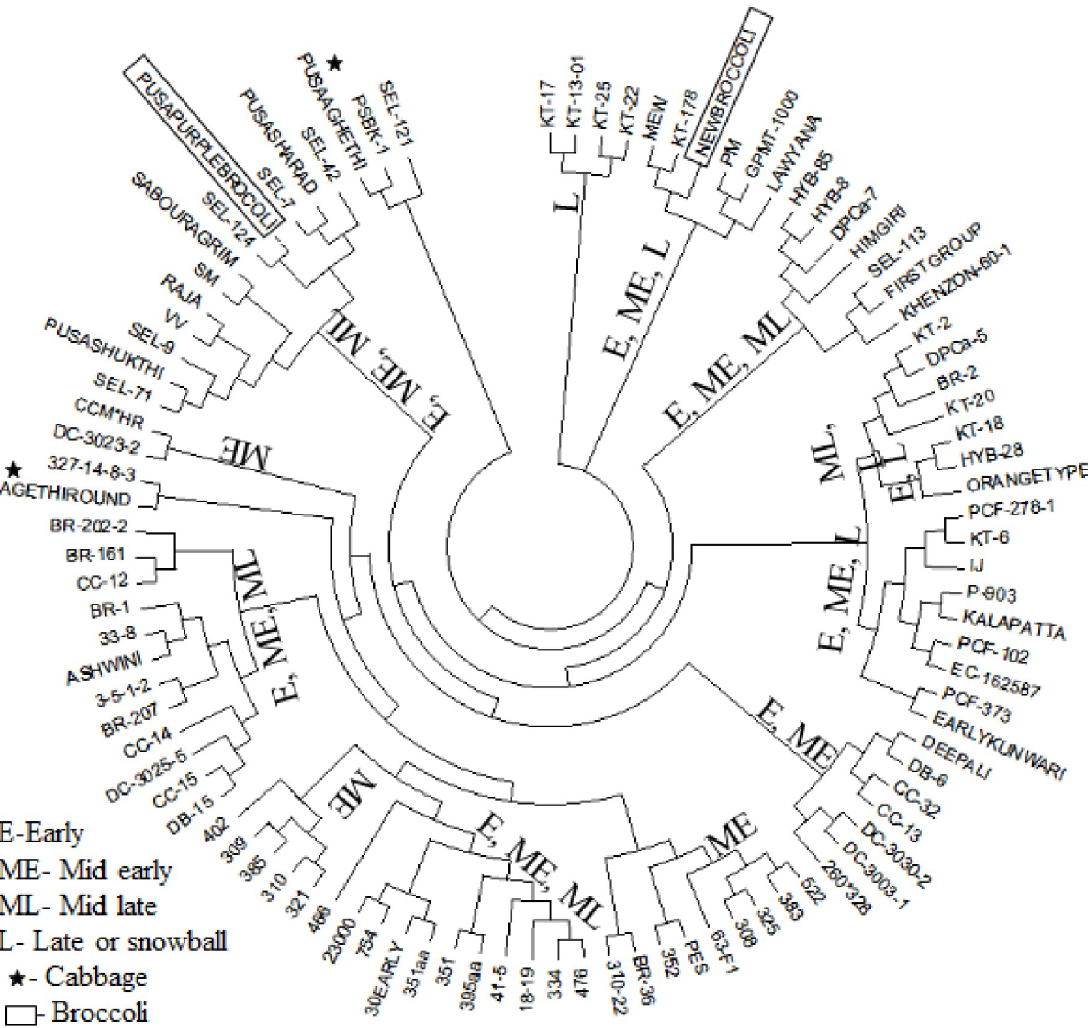
Fig 4. Dendrogram showing dissimilarity using UPGMA cluster analysis demonstrating association among 96 genotypes of cauliflower and related crops.